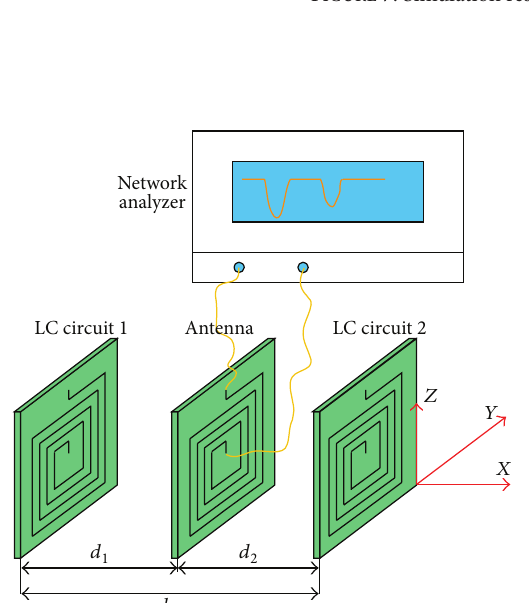
Figure 7: Simulation results upon changing (a) 𝑘 1 and (b) 𝑘 2 .